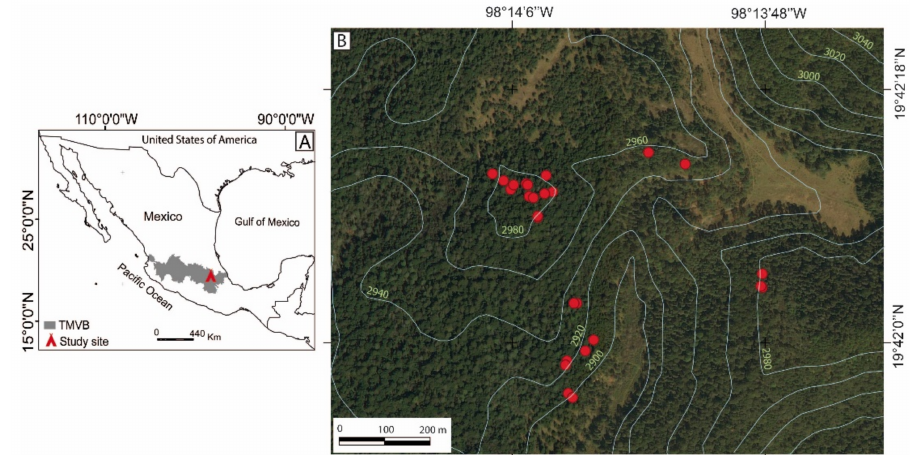
Figure 1. ( A ) Location of the study area in the Trans-Mexican Volcanic Belt (TMVB) and ( B ) distribution of sampling points (red dots) in the Abies religiosa forest in the Sierra Norte de Puebla, Mexico. The white lines are a 20-m interval contour line (altitude m a.s.l.).